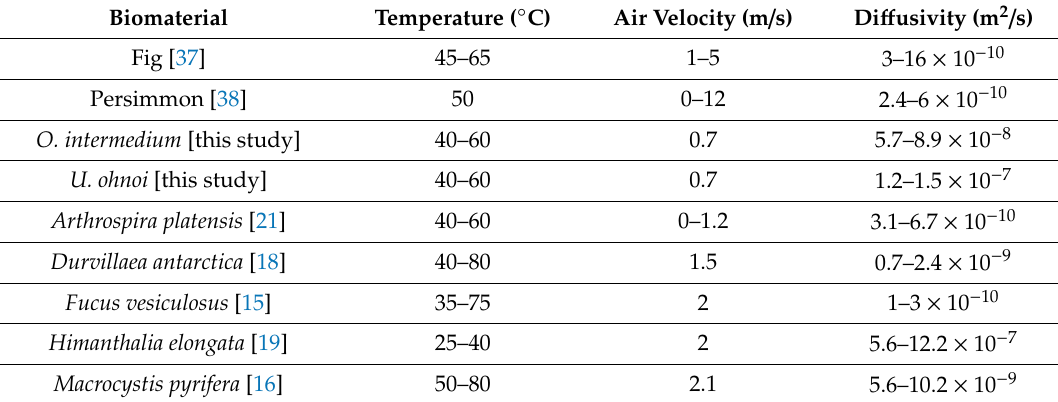
Table 4. Examples of e ff ective di ff usivity values for various biomaterials during convective